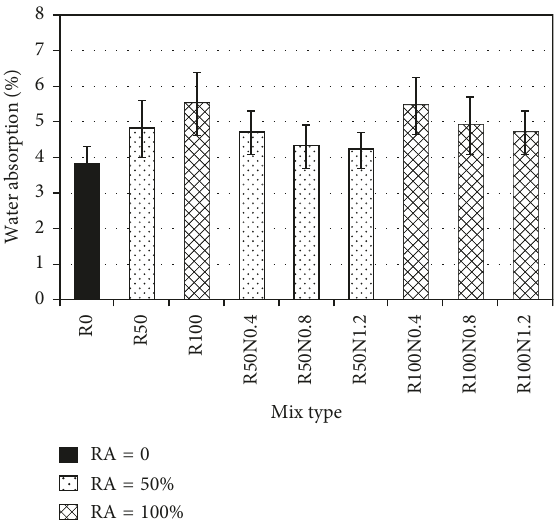
Figure 7: Water absorption (WA) of all mixes.